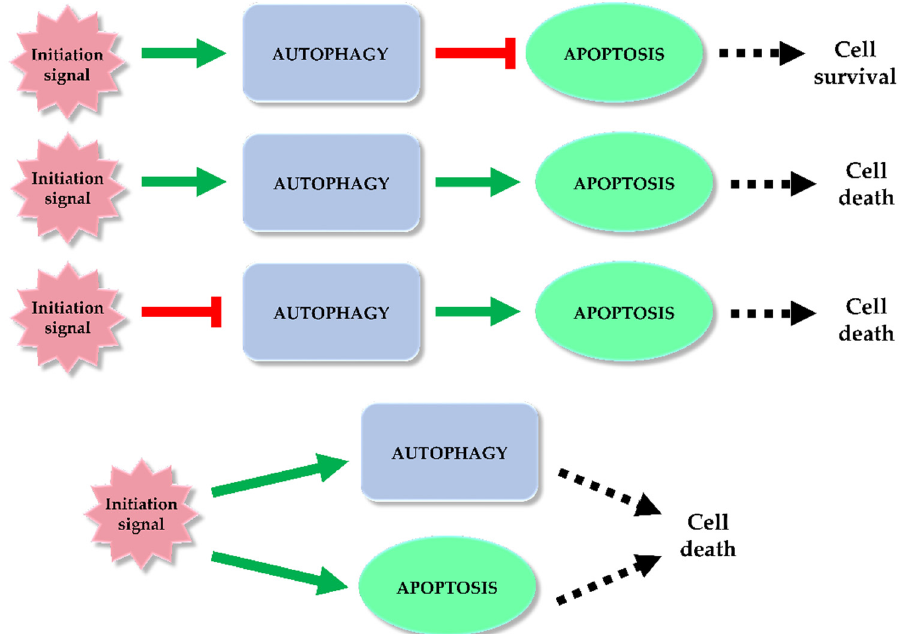
Figure 5. Autophagy and apoptosis relationship. Among the potential correlation pathways between autophagy and programmed cell death we can distinguish: activation of autophagy and apoptosis inhibition, activation of autophagy and activation of the apoptotic pathway, autophagy suppression and induction of apoptosis or simultaneous activation of autophagy and apoptosis leading to ADCD and apoptosis. The inhibitory effect of each process (red mark) and inducting effect (green mark) is indicated on the scheme.